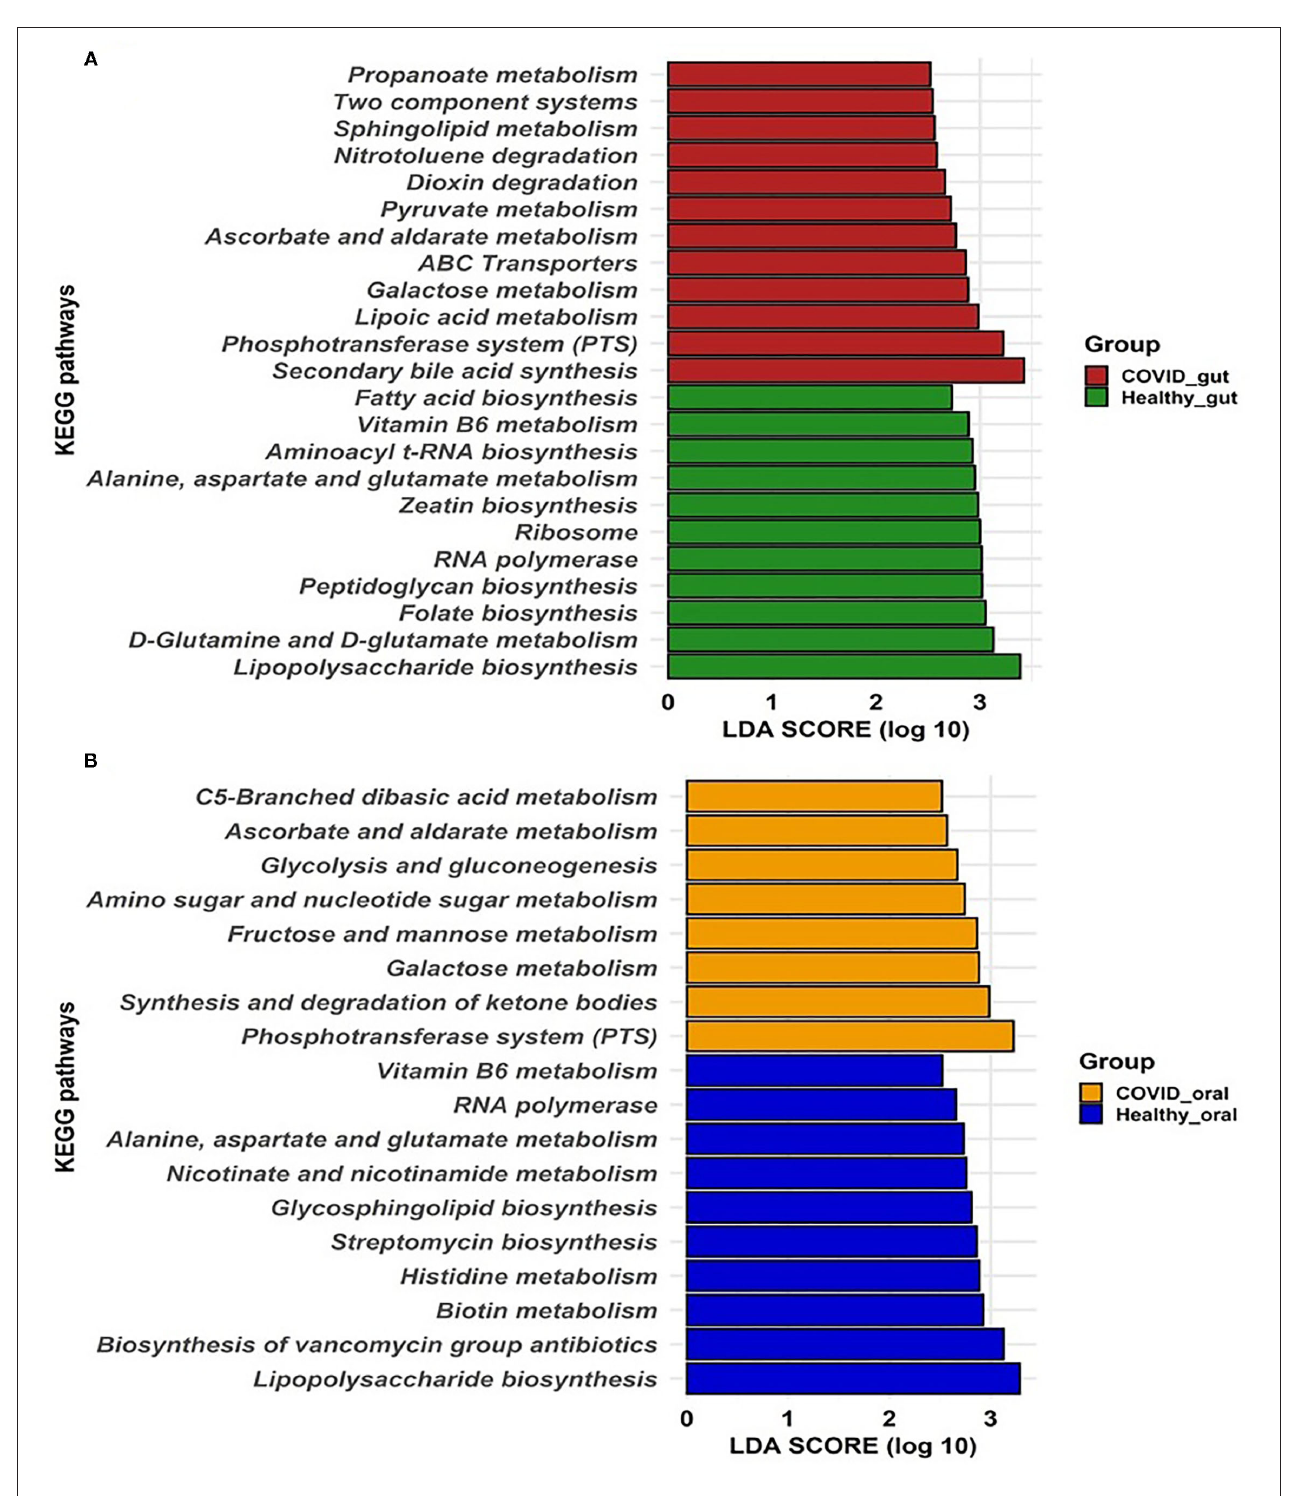
FIGURE 6 | Predicted differentially expressed metabolic pathways in the gut (A) and oral wash (B) of healthy controls and COVID-19 cases. A total of 23 and 18 KEGG pathways were predicted in the gut and oral samples, respectively. Histogram showing linear discriminant analysis (LDA) score from 0 to 3 represents the expression pattern of pathways in each category of